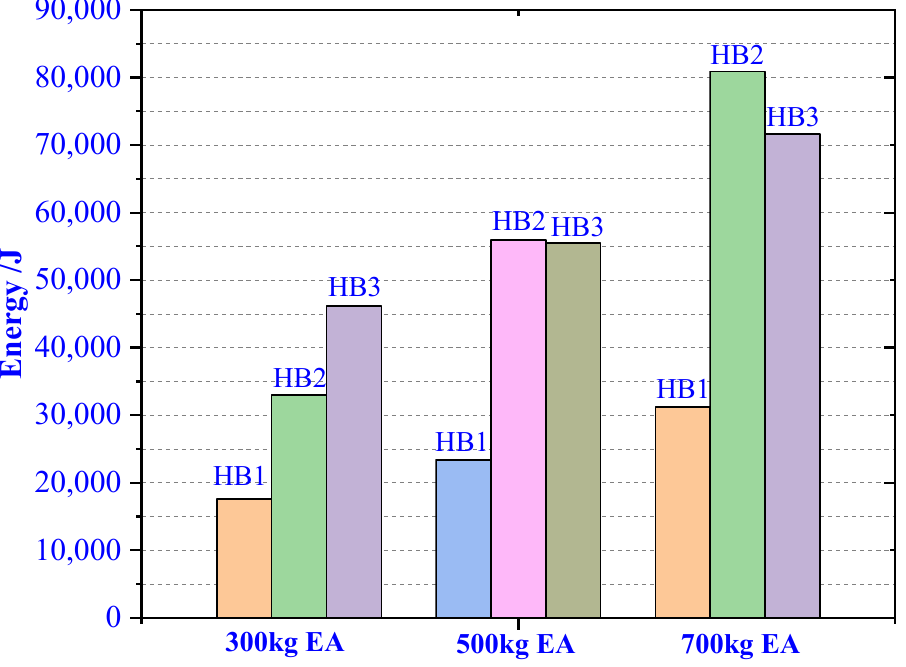
Figure 11. Three masses of material absorb energy.